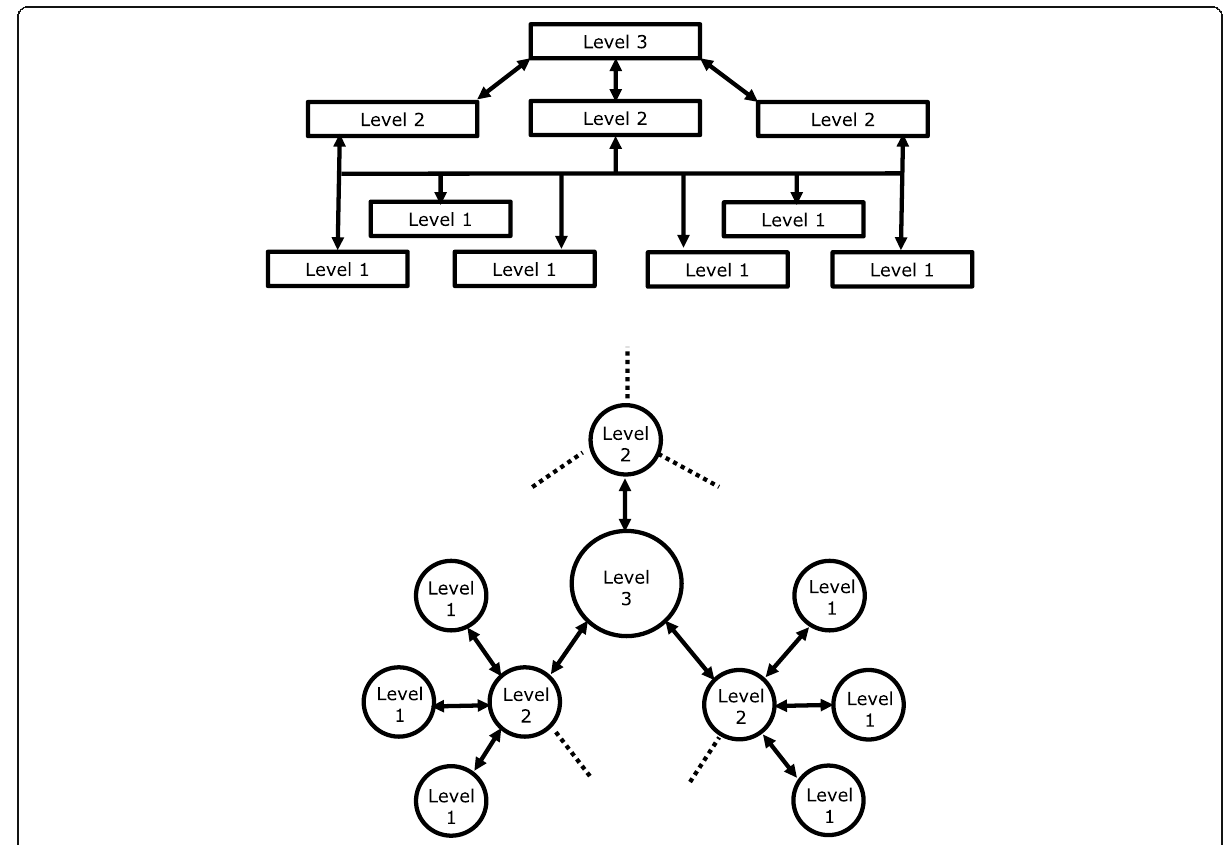
Fig. 3 Layered (above) and hub-and-spoke (below) structures. The bi-directional arrows indicate patient flows from lower levels to higher, and clinical and educational supports from higher to lower. Each structure is amenable to top-down or bottom-up organization for integration within existing health services, although bottom-up is more likely in layered structures and top-down in hub-and-spoke. Hybrid structures are